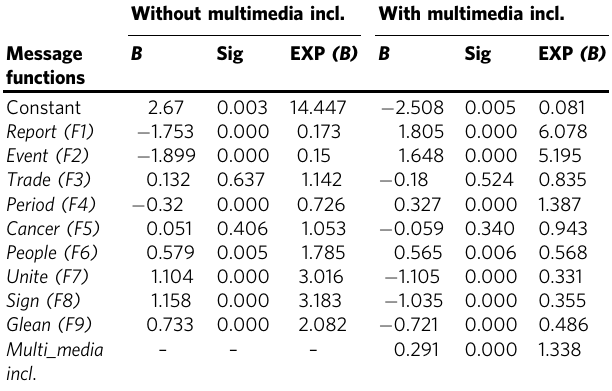
Table 7 Effects of communication functions on user engagement (with and without multimedia inclusion), normalized by logarithm and number of followers. Without multimedia incl. With multimedia